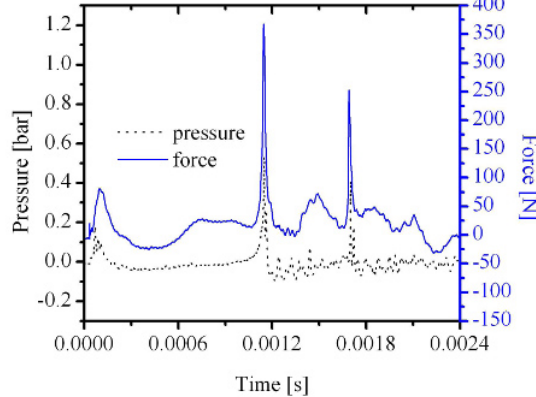
Fig. 6. Collapse pattern 2 – hydrophone and PVDF film signals.